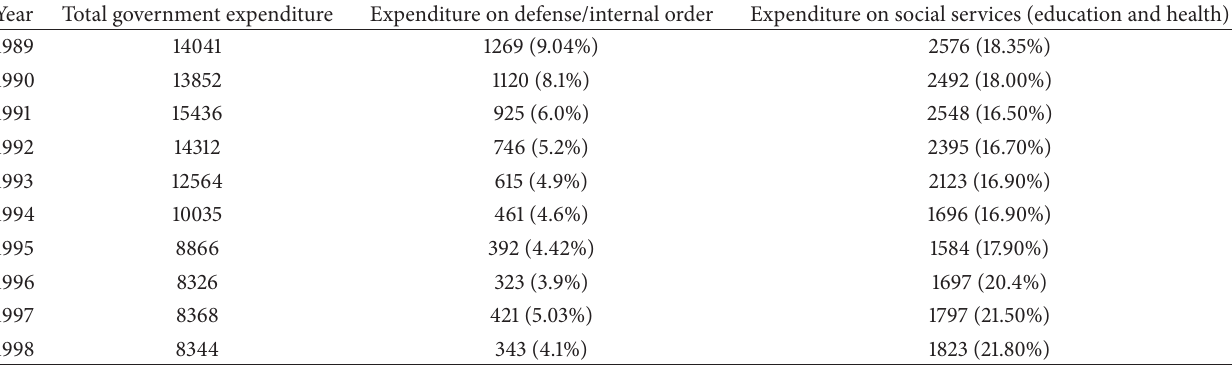
Table 15: Cuba’s total government expenditure and expenditure on social services (including health) and defense during the special period (in millions of current Cuban Pesos).